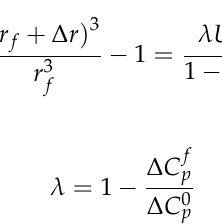
Figure 7. ( a ) Surface microphotograph of 0.2 mm aluminum–particle epoxy composite with filler content 15%. Magnification 250×; ( b ) Cambridge S4-10-type SEM.